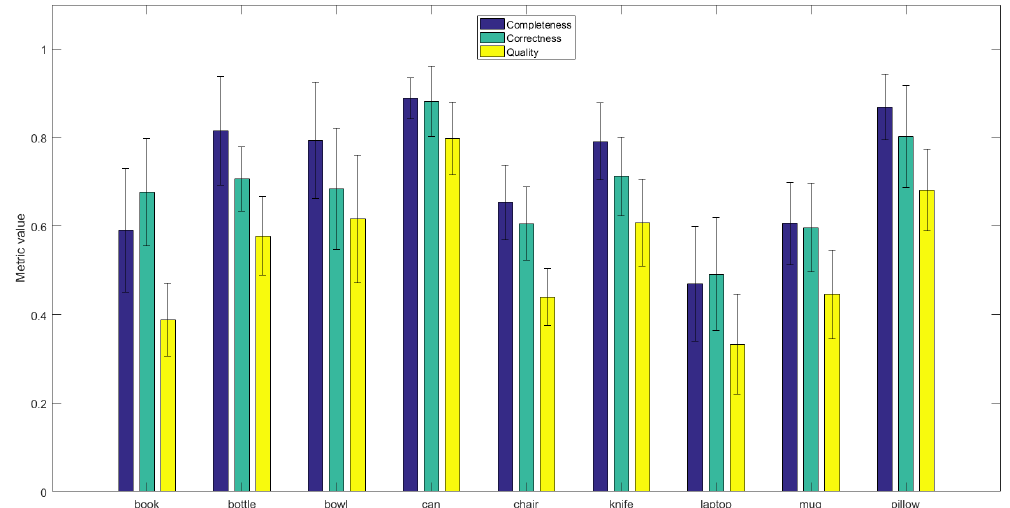
Figure 9. Comparison of reconstruction results using Completeness , Correctness , and Quality ) metric values.